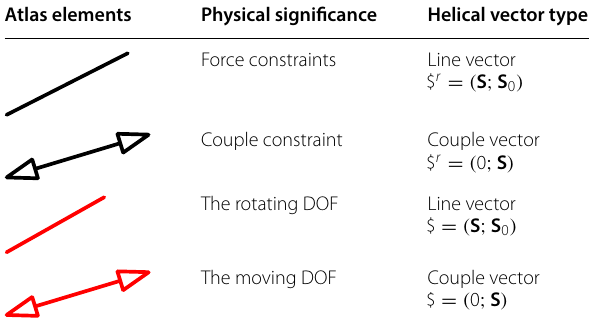
In the table, $ r and $ are the spiral expressions of constraints and movements